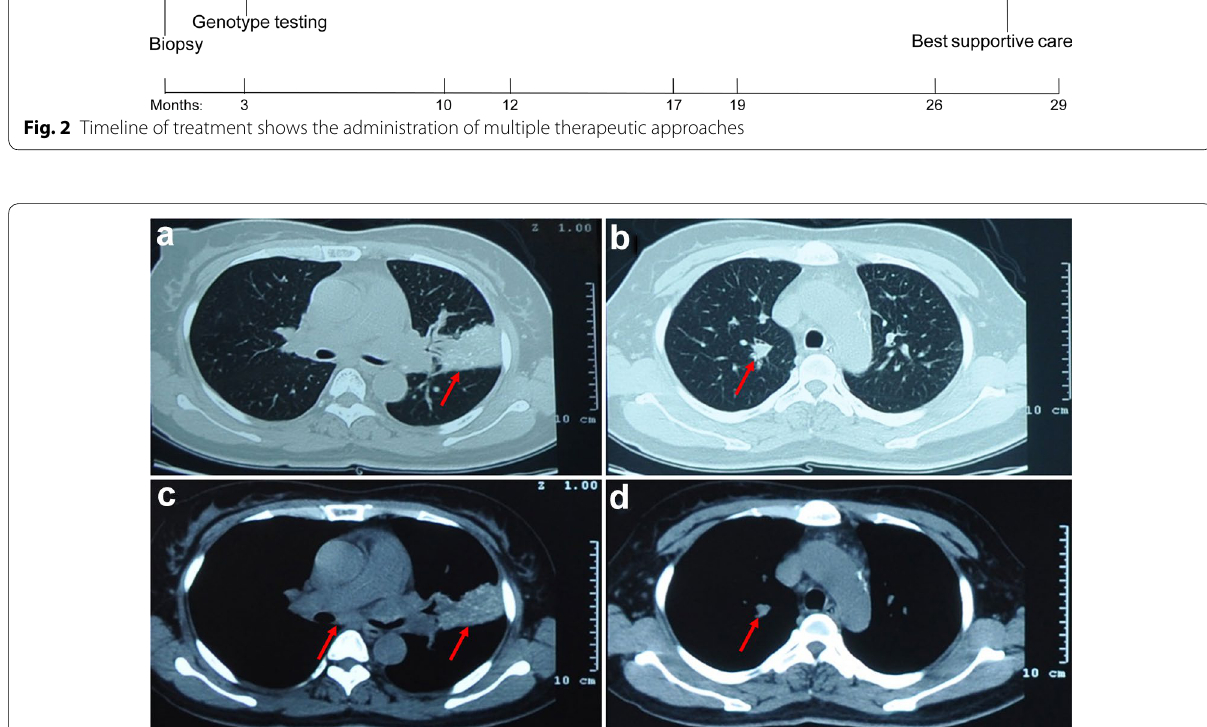
Fig. 3 Imaging examination confirmed the disease progression after two cycle inducing chemotherapy. a , c The primary lesion on the lower left lobe was larger than before. b , d New metastasis in the right upper lobe was found